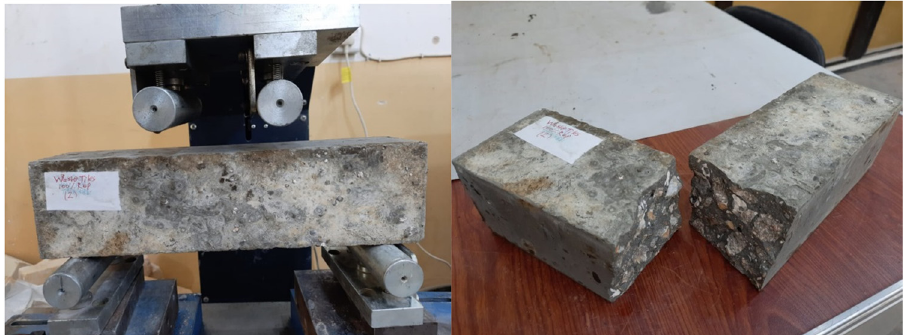
Figure 3: Flexural strength test for 100% waste tile concrete – modi fi ed